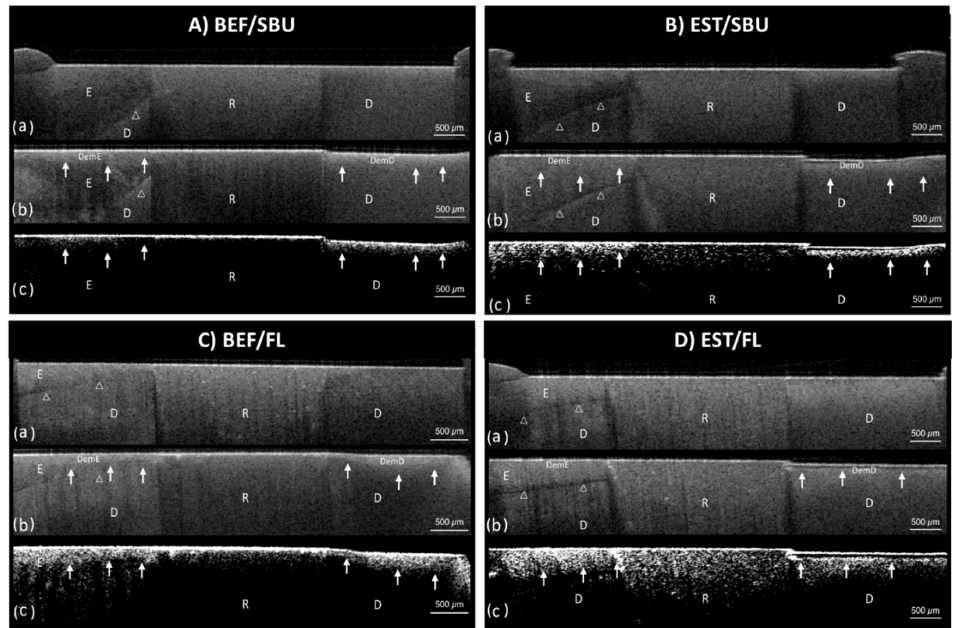
Figure 3. Representative cross-sectional image set of SS-OCT by de/re-mineralization cycling (pHC) model for four groups, ( A ) BEF/SBU, ( B ) EST/SBU, ( C ) BEF/FL, and ( D ) EST/FL group. ( a ) SS-OCT image before demineralization. A thin layer of wax was applied from the restored cavity margin. White-outlined arrowheads show the dentin–enamel junction. ( b ) SS-OCT image after demineralization. Solid white arrows show lesion boundaries under the demineralized enamel and demineralized root dentin. ( c ) SS-OCT image after the application of a noise reducing median filter. BEF—Beautifil II ® composite, EST—Estelite ® composite, SBU—Single Bond Universal ® adhesive, FL—FL Bond II ® adhesive, E—enamel, D—root dentin, R—resin.